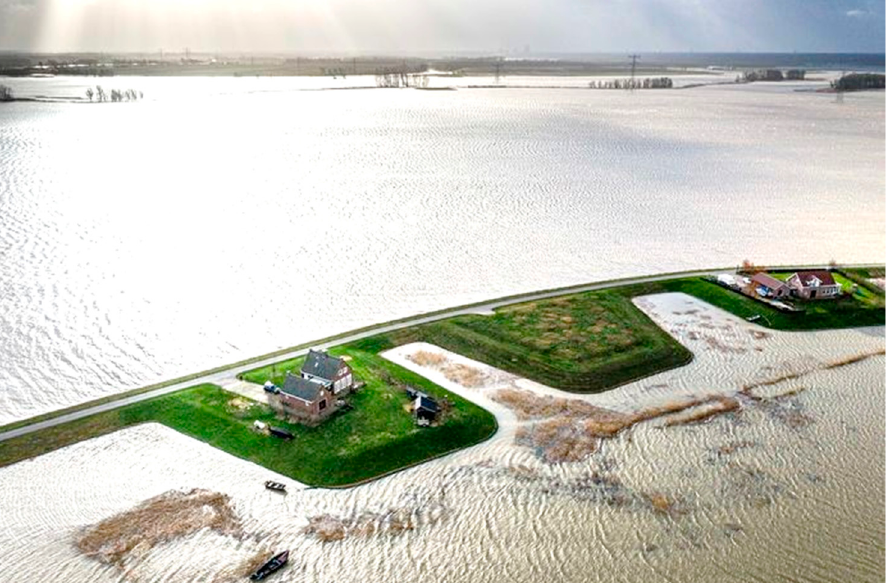
Figure 6. Relocated houses on flood-free mounds in Noordwaard flood storage and bypass area (picture from Brabants Dagblad).